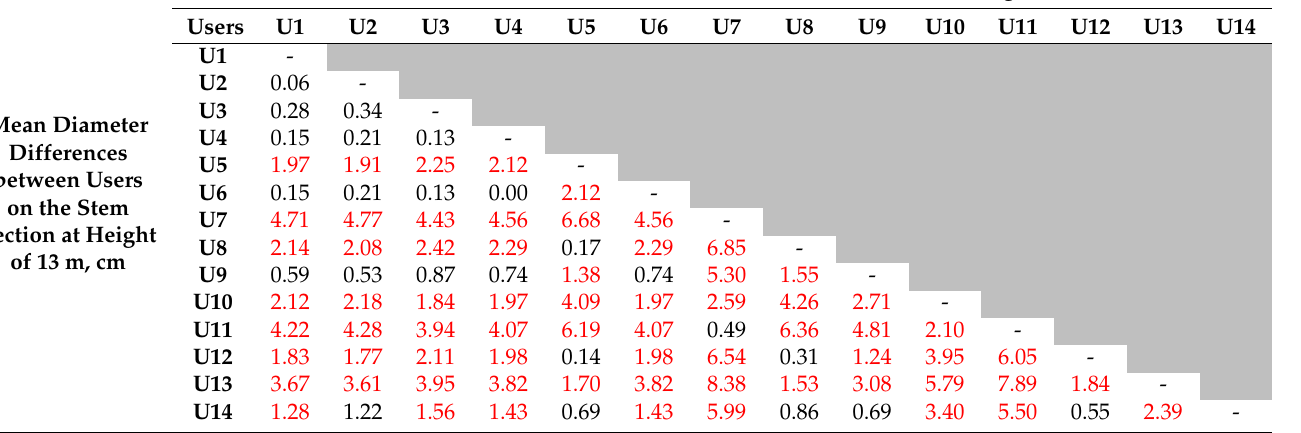
Table A6. Differences between mean diameters obtained by each user when a laser caliper was used to measure upper-stem diameters at a height of 13 m. The red values denote significant differences between the mean diameters obtained by the